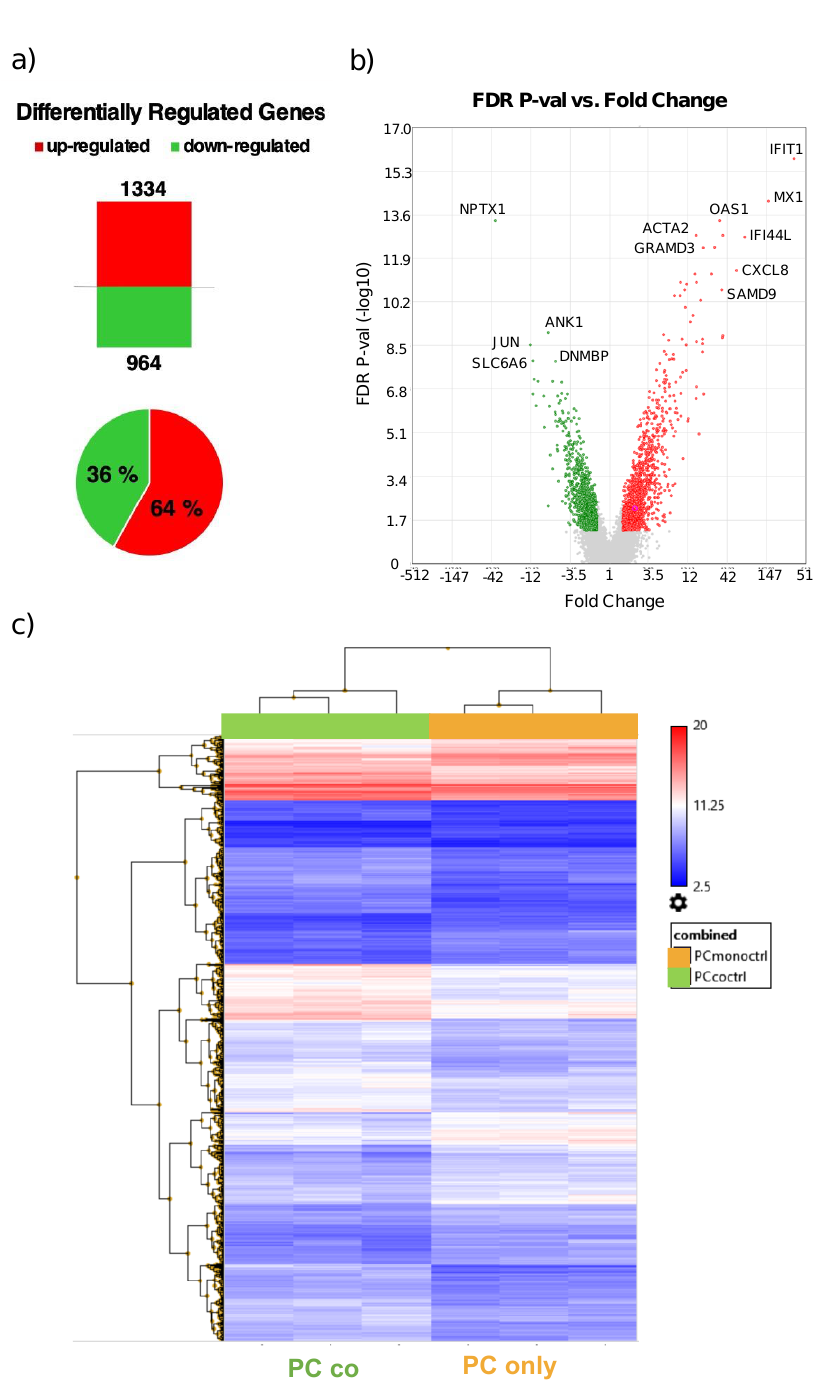
Figure 2. Differentially regulated genes (DRGs). Number of differentially regulated genes (DRGs) in PCs co-cultured with ECs vs. PCs cultured alone and pie chart representation denoting up- and downregulated genes in % of total number of DRGs. Upregulated genes are depicted in red and downregulated genes in green ( a ). Volcano plot showing FDR p -Value ( − log10) on the y -axis vs. fold change of DRGs on the x -axis. Up- and downregulated genes are depicted in red and green, respectively ( b ). Heatmap representation of DRGs between co- and mono-cultured PCs ( c ). Comparison of gene expression data of co-cultures vs. mono-cultures of PCs in triplicates was performed by using Transcriptome Analysis Console (TAC, Applied Biosystems by Thermo Fisher Scientific Inc, Waltham, MA, USA)). For the analysis, a fold change (FC) cut-off of 1.5 (log2FC +/- 0.59) and FDR p -Value of 0.05 was applied.